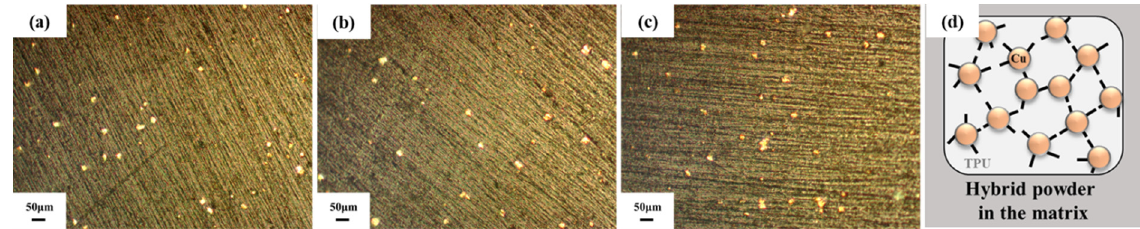
Figure 3. OM images of the TPU/Cu/CNTs filament cross section after extruding ( a ) 15, ( b ) 17.5, and ( c ) 20 vol.%; ( d ) schematic of the hybrid particles in the matrix.